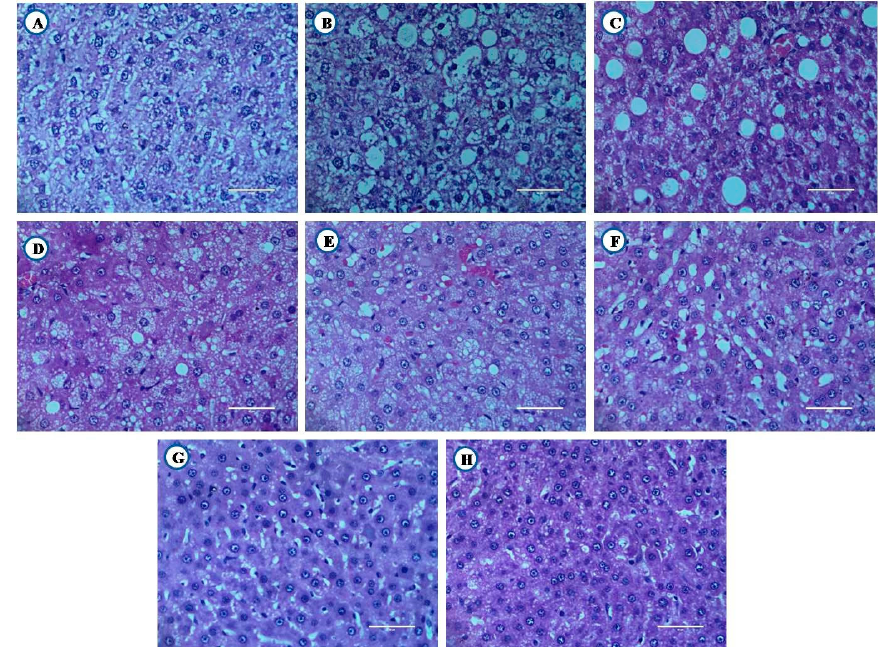
Figure 11. Histological examination of liver tissue (Scale bar 50 µ m). Healthy. ( A ) Healthy control, ( B ) High fat diet control, ( C ) Diabetic control, ( D ) Glibenclamide control, ( E ) Statin control, ( F ) Glibenclamide statin control, ( G ) Flax oil (500 mg / kg), ( H ) Flax oil (500 mg / kg).